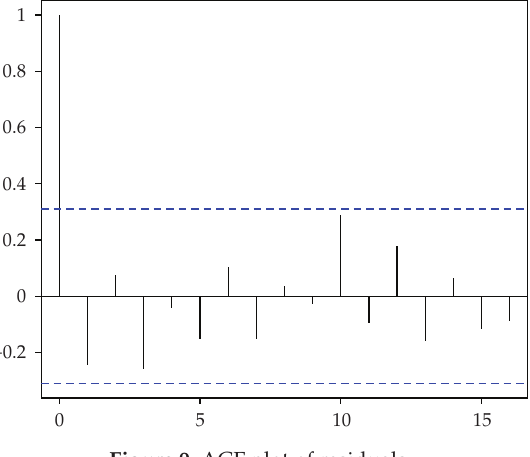
Figure 9: ACF plot of